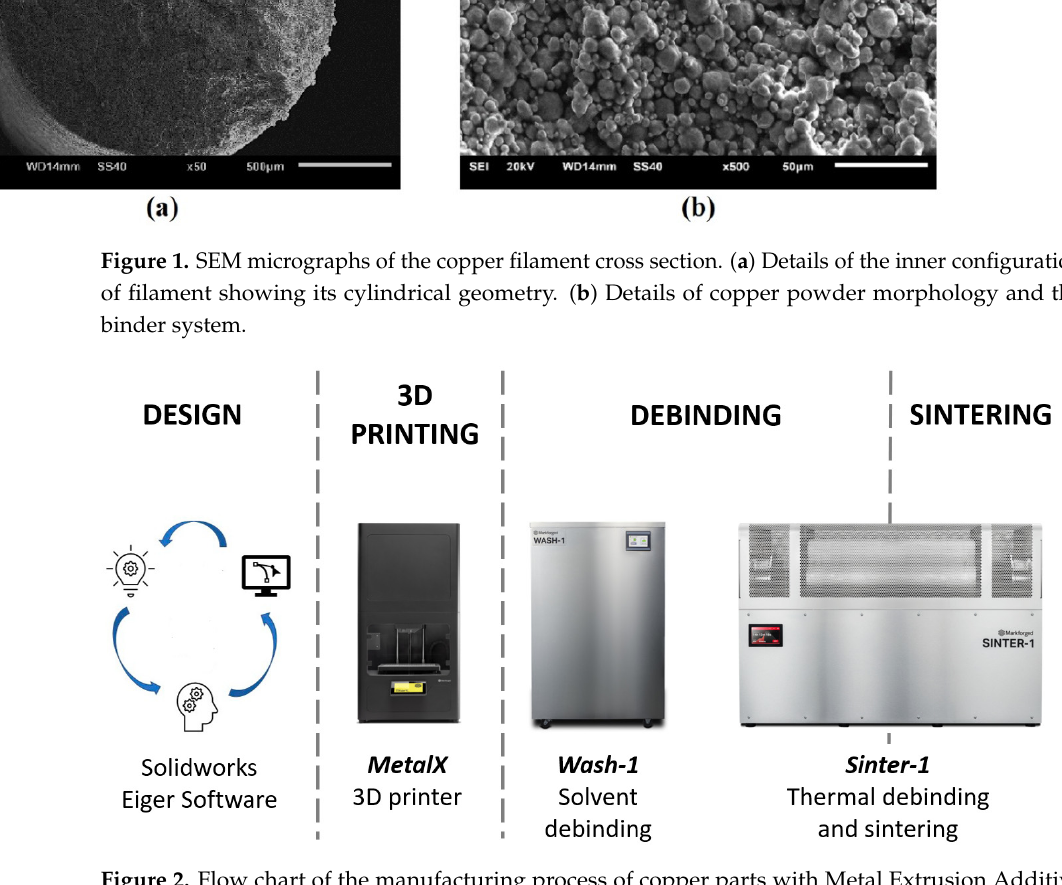
Figure 1. SEM micrographs of the copper filament cross section. ( a ) Details of the inner configura- tion of filament showing its cylindrical geometry. ( b ) Details of copper powder morphology and the binder system.